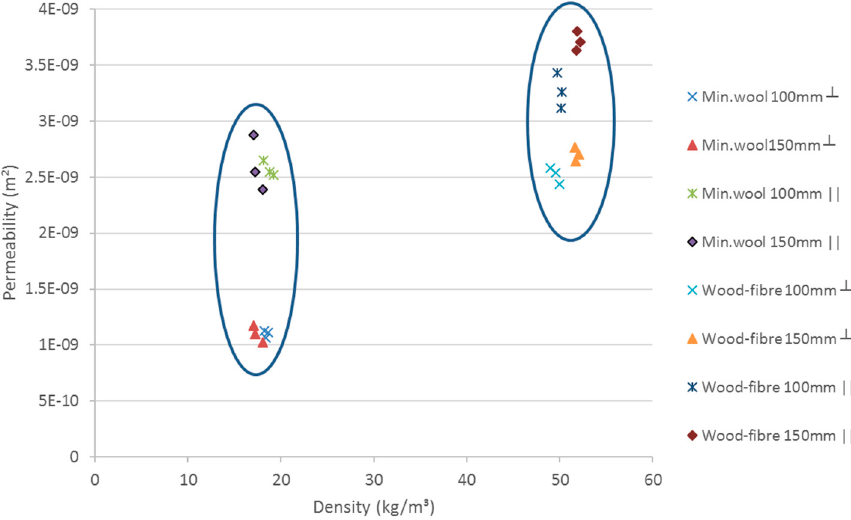
Figure 3. Measured permeability perpendicular and parallel to the main fibre direction performed with mineral wool and wood-fibre insulation.